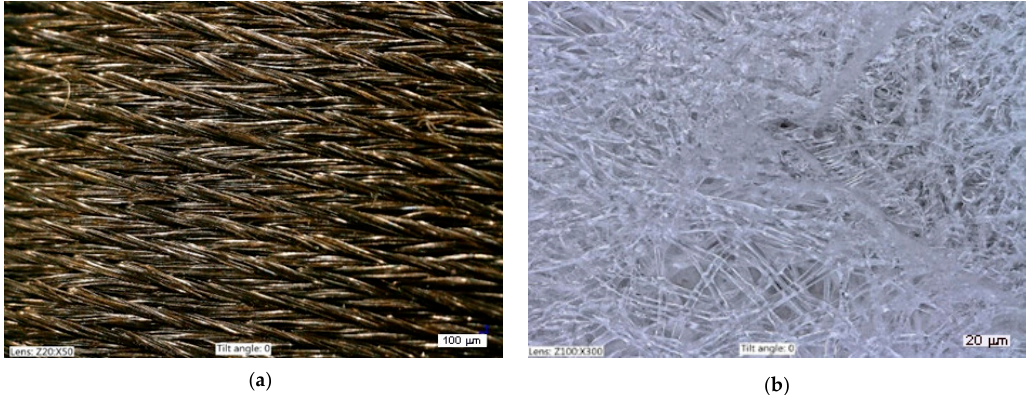
Figure 7. Microscopic images of textile electrodes ( a ) used in the modified TipStim solution. ( b ) Fibrous substrate of the Optisana patch.